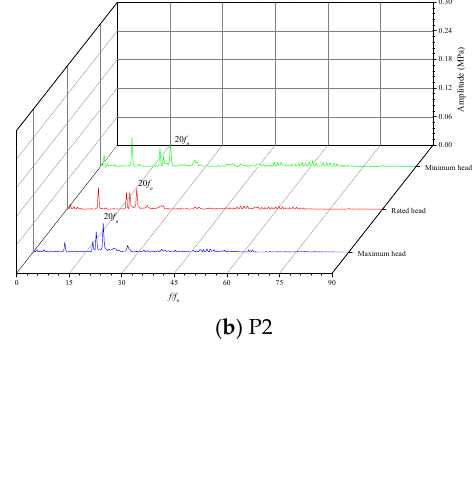
Figure 11. Dynamic stresses at monitoring points. The frequency spectra of the dynamic stresses at the monitoring points are shown in Figure 12. It can be seen that the frequency spectra of the dynamic stresses are different at different monitoring points. The RSI frequency is the dominant frequency of the dynamic stress at the leading edge of the blade (P1, P2, P7, P8). At the trailing edge of the blade, the dominant frequency of the dynamic stress is not the RSI frequency, this is because of the frequency spectra of the pressure pulsation. The operating head has little effect on the frequency spectra of the dynamic stress; only the dominant frequency of the dynamic stress at P5 changes from 17 𝑓 (cid:3041) at minimum head and rated head to 18 𝑓 (cid:3041) at maximum head.